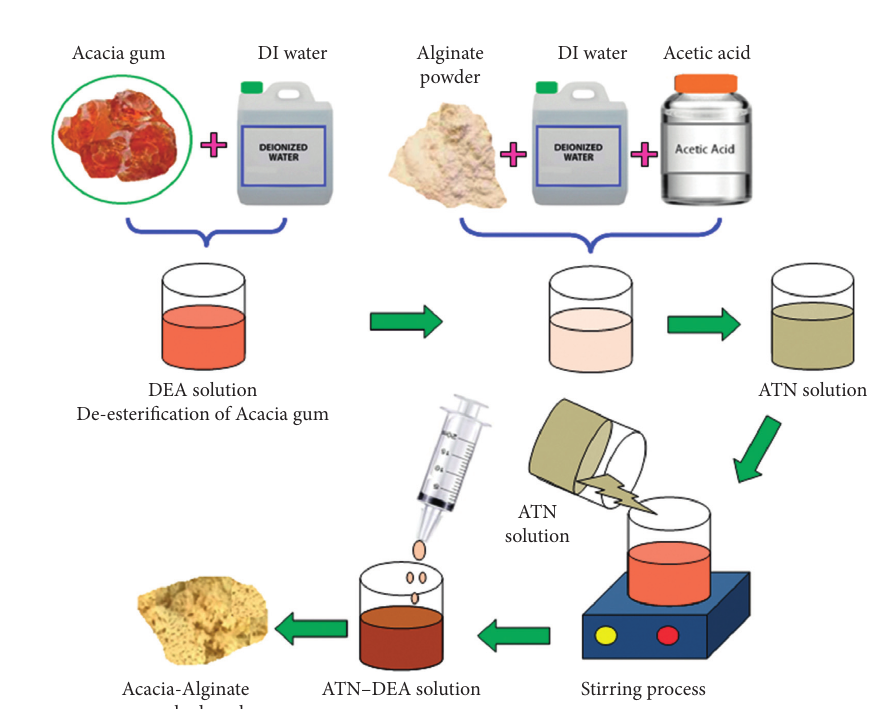
Figure 1: Flow process of acacia-alginate nanohydrogel formation. Table 2: Experimental process parameters and response summary of nanohydrogel preparation. Exp.